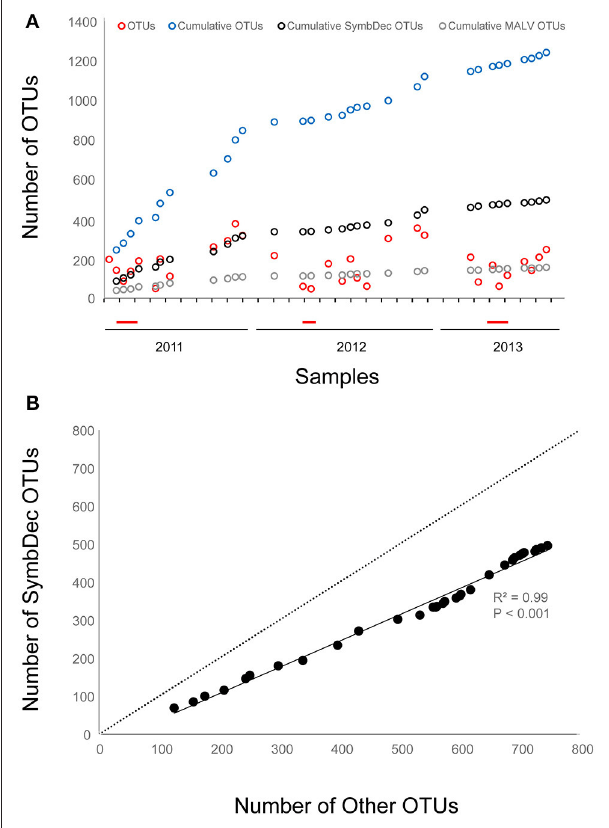
FIGURE 4 | Absolute (A) and relative (B) number of Operational Taxonomic Units (OTUs) in the trophic groups detected during the study. The trophic groups were formed based on the trophic status of the detected OTUs in marine systems as inferred from the literature (see Table 1 ). The red line on the x-axis indicates periods of the P. globosa bloom.